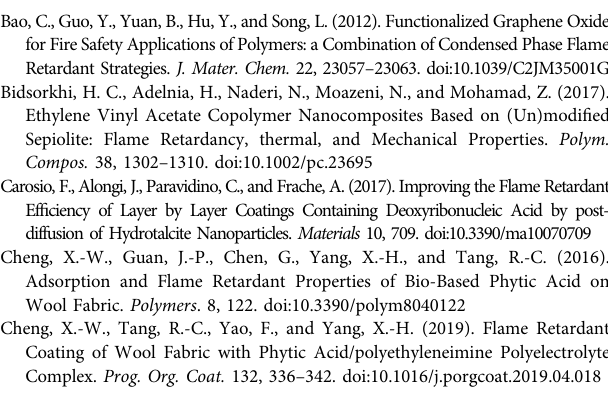
Frontiers in Materials |